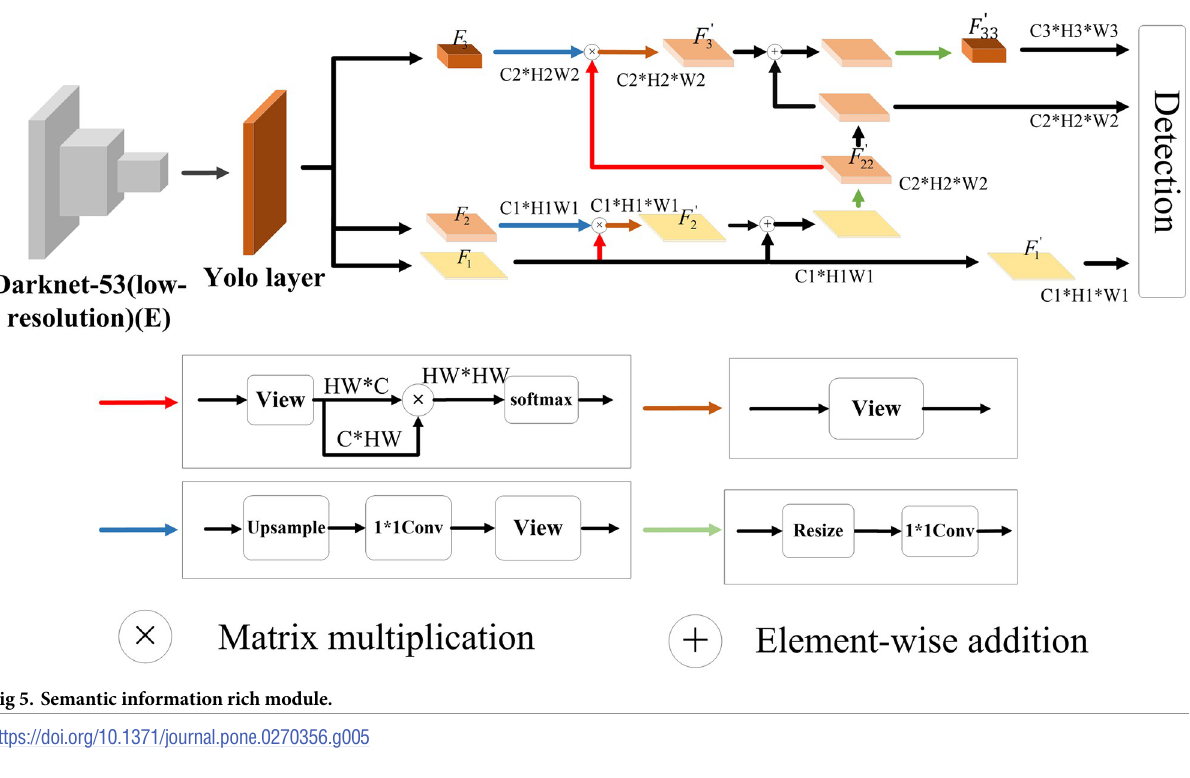
Fig 5. Semantic information rich